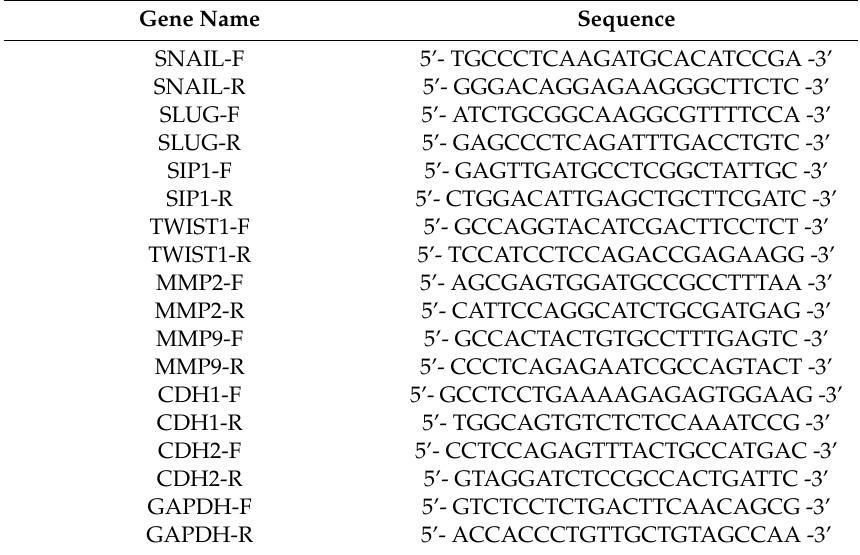
Table 2. Primers for